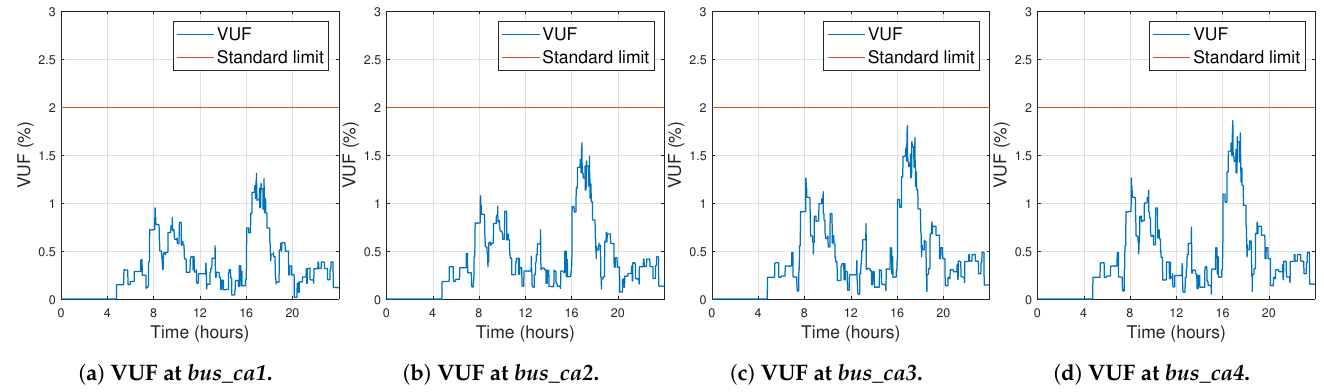
Figure 10. The VUF variation during the simulated day at the main buses: ( a ) bus_ca1 , ( b ) bus_ca2 , ( c ) bus_ca3 , and ( d ) bus_ca4 (farthest main bus from the bus_STEG ).